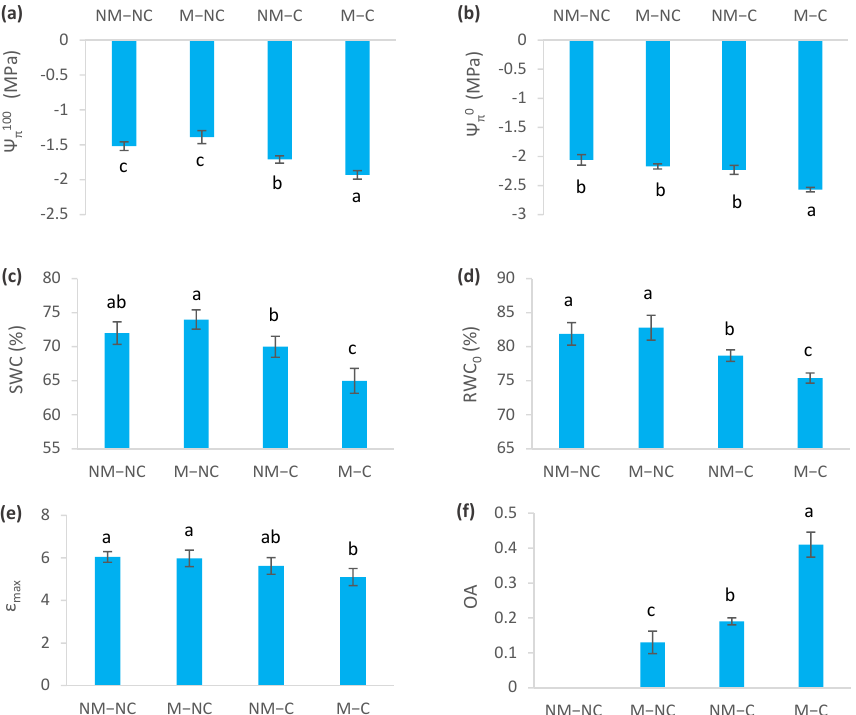
Figure 4. Osmotic potential at saturation ( Ψ π 100 ) ( a ), osmotic potential with loss of turgor ( Ψ π 0 ) ( b ), symplastic water content (SWC) ( c ), relative water content at loss of turgor (RWC 0 ) ( d ), modulus of elasticity ( ε max ) ( e ), and osmotic adjustment (OA) ( f ) of ectomycorrhizal (M) and non-ectomycorrhizal (NM) Pinus halepensis seedlings after 12 months of growth in contaminated (C) and control soil (NC). Means (± SD; n = 8), with different letters indicating significant differences from one another based upon Tukey’s tests at p ≤ 0.05.